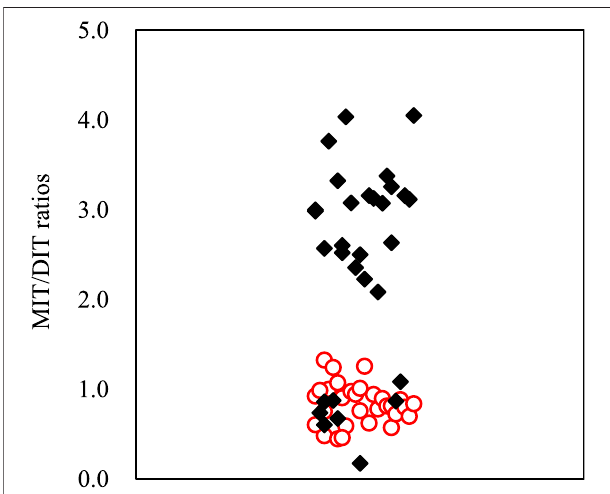
FIGURE 4 | Concentration ratio of MIT and DIT in water (red circle) and sediment samples (black diamond shape) from Taihu Lake.